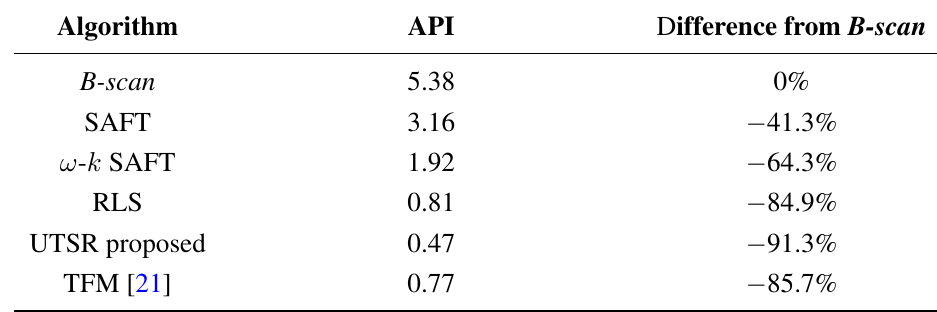
Table 2. API for images reconstructed from experimental data. SDH geometrical center at z = 40 mm.